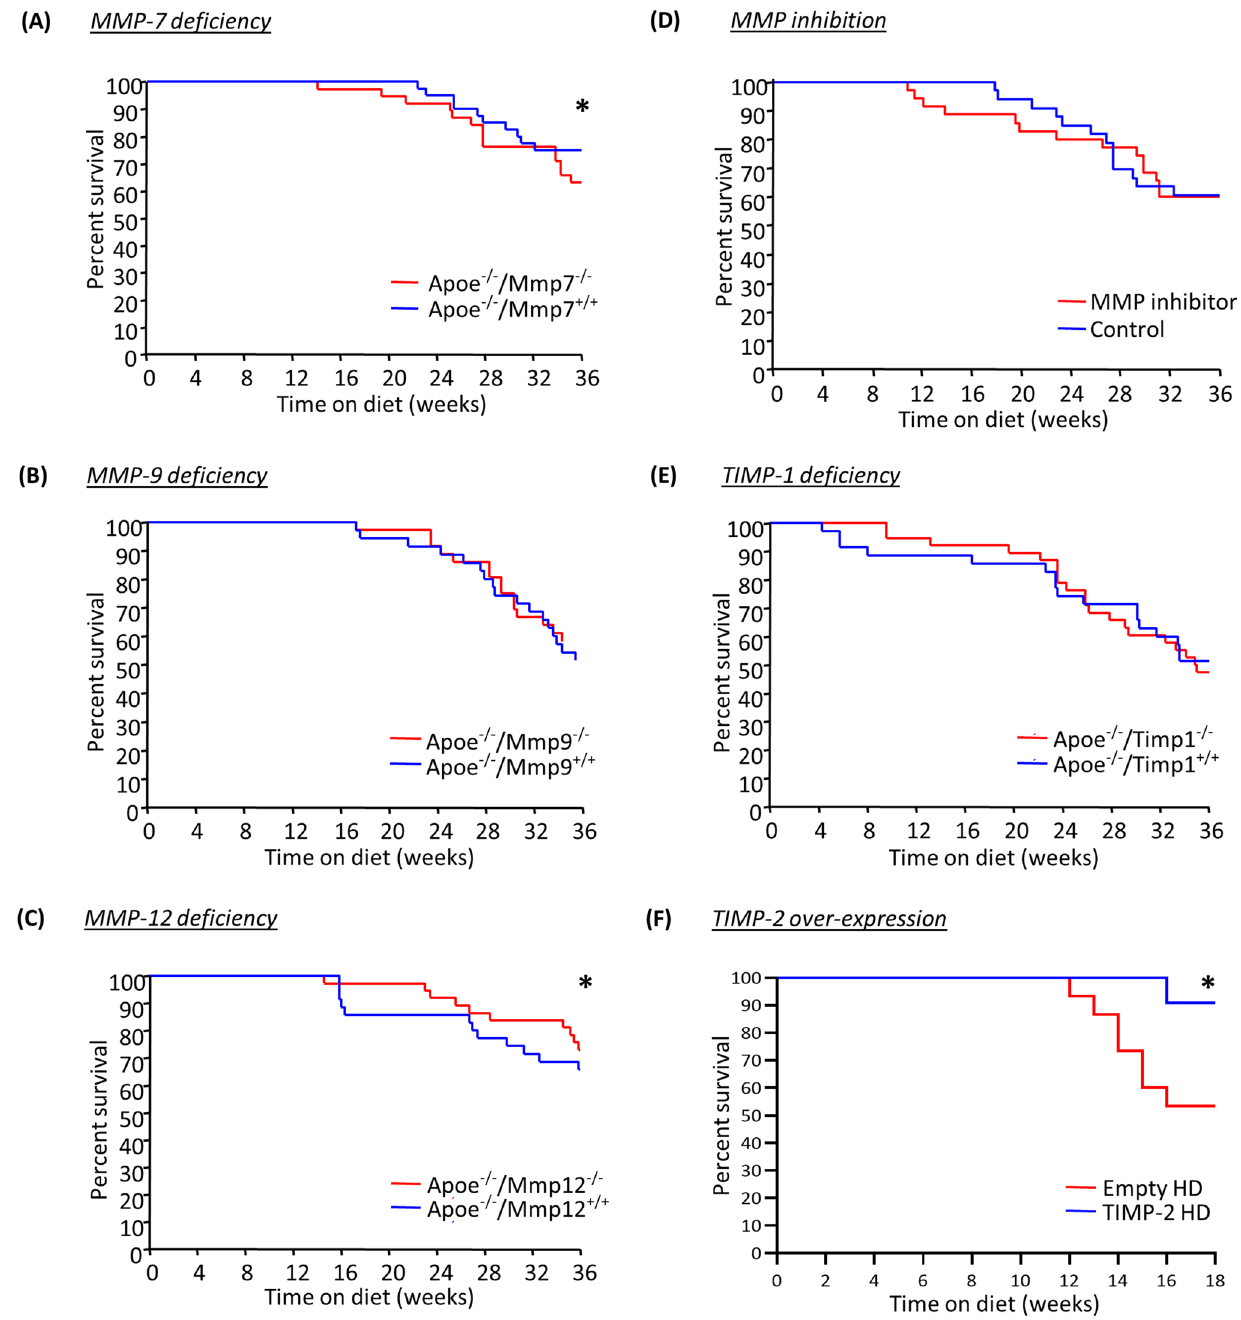
Figure 1. Effect of MMP/TIMP modulation on sudden death in apolipoprotein E-deficient (Apoe -/- ) mice. ( A – D ) Kaplan–Meier curves of percent survival in 36-week high-fat fed Apoe -/- mice also deficient for ( A ) MMP-7, ( B ) MMP-9, ( C ) MMP-12, or ( D ) TIMP-1 in comparison to their respective Apoe single knockout controls. ( E ) Kaplan–Meier curve of percent survival in 36-week high-fat fed Apoe -/- mice treated with a broad- spectrum MMP inhibitor, both delayed and throughout, or without. ( F ) Kaplan–Meier curve of percent survival in 18-week high-fat fed Apoe -/- mice with administration of a TIMP-2 helper-dependent (HD) adenovirus or an empty HD as control. Statistical comparisons were made using log-rank test, with * P < 0.05. In A-E, n = 36/ group; in F, n =